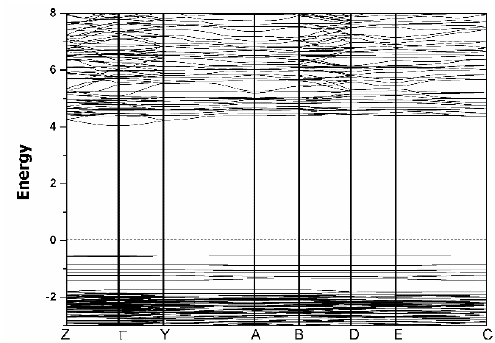
Figure 6. The calculated band structure of Na 4 Yb(CO 3 ) 3 F.